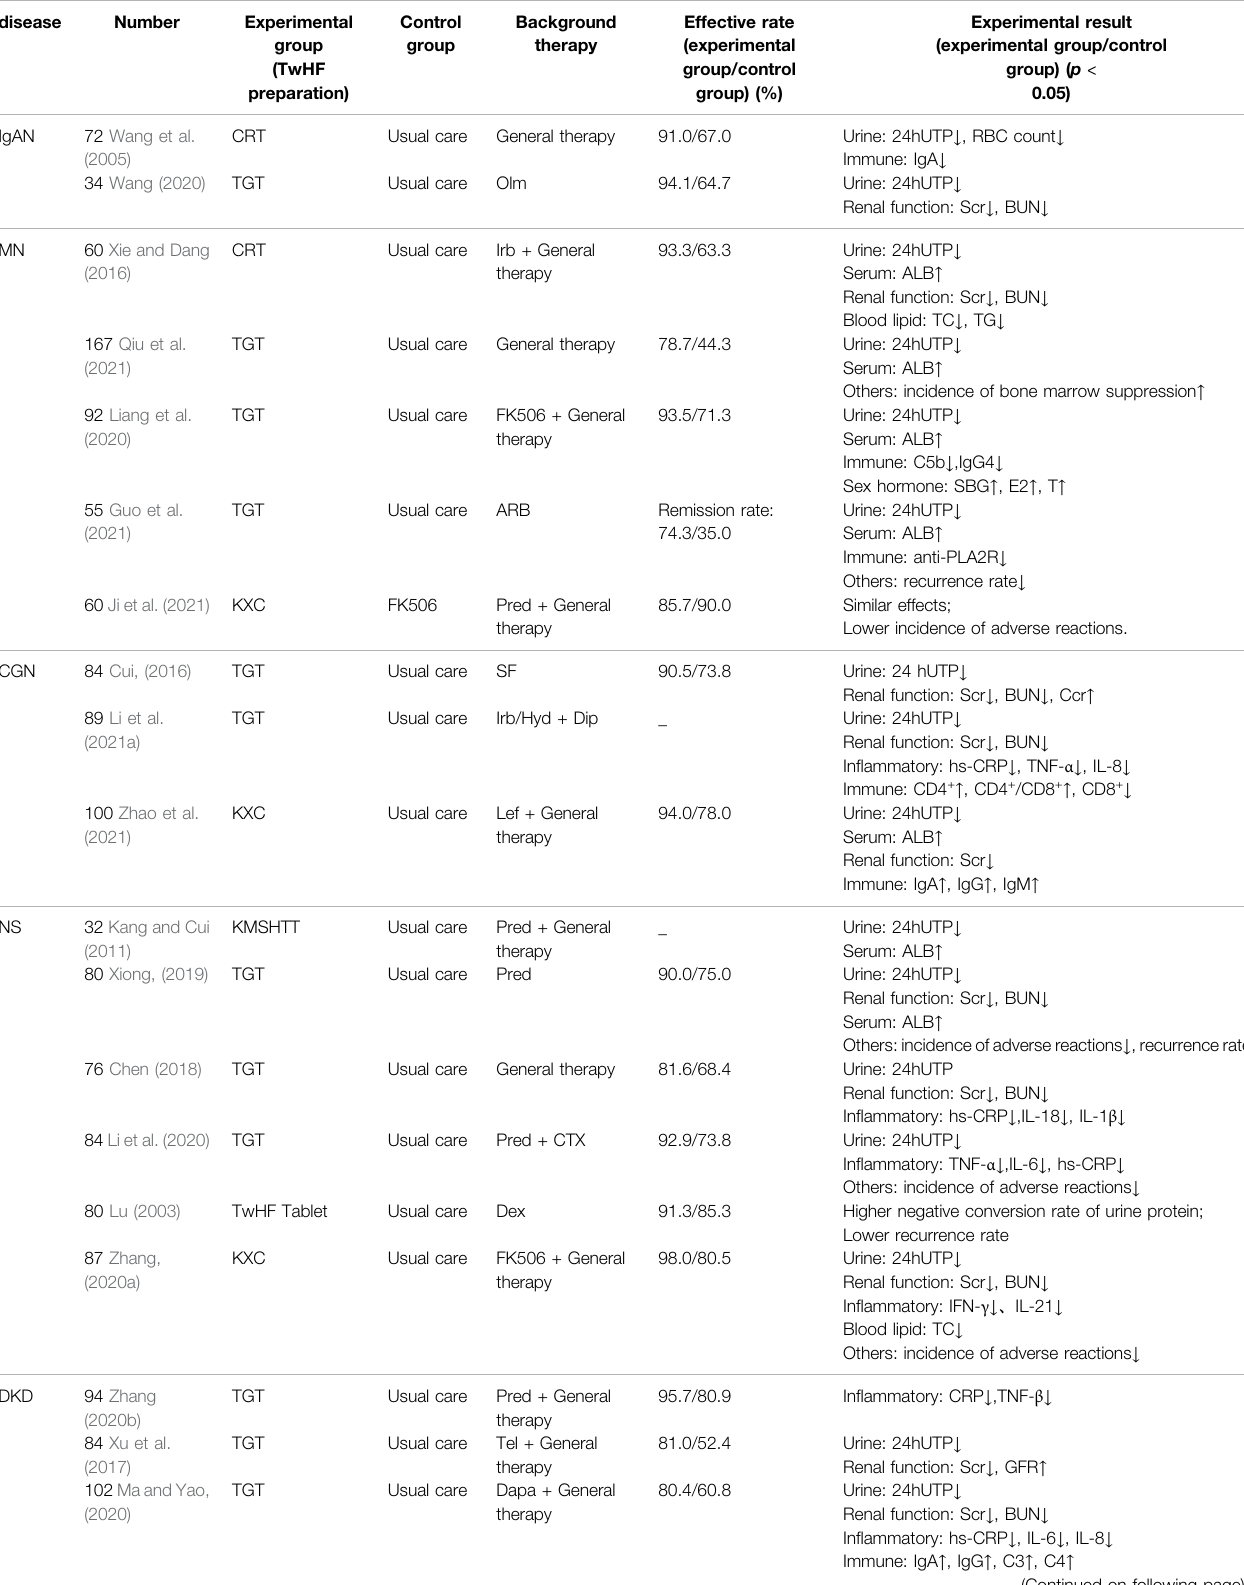
TABLE 4 | Clinical studies of TwHF preparations on the treatment of kidney diseases.